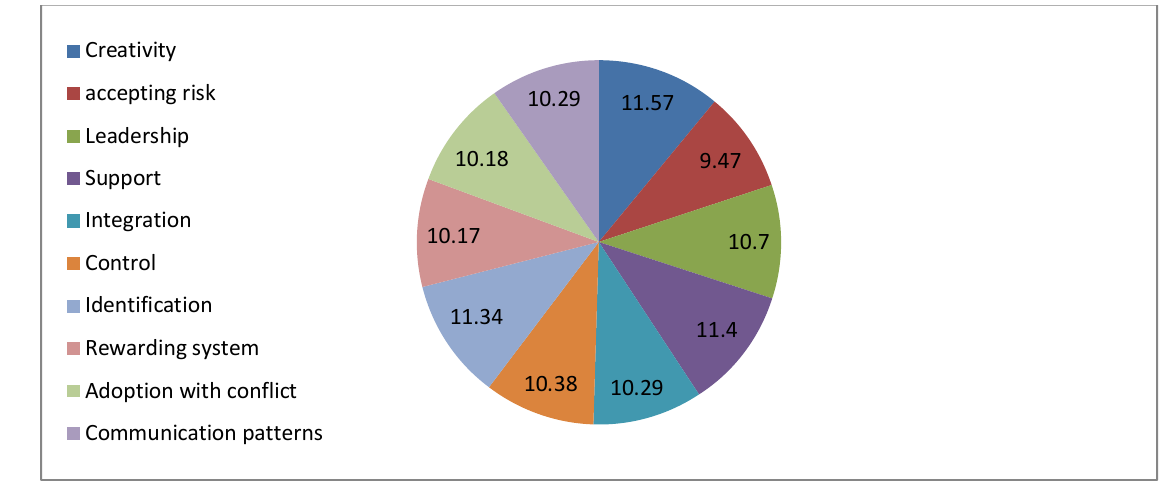
Fig. 1. The summary of mean for different components of organizational